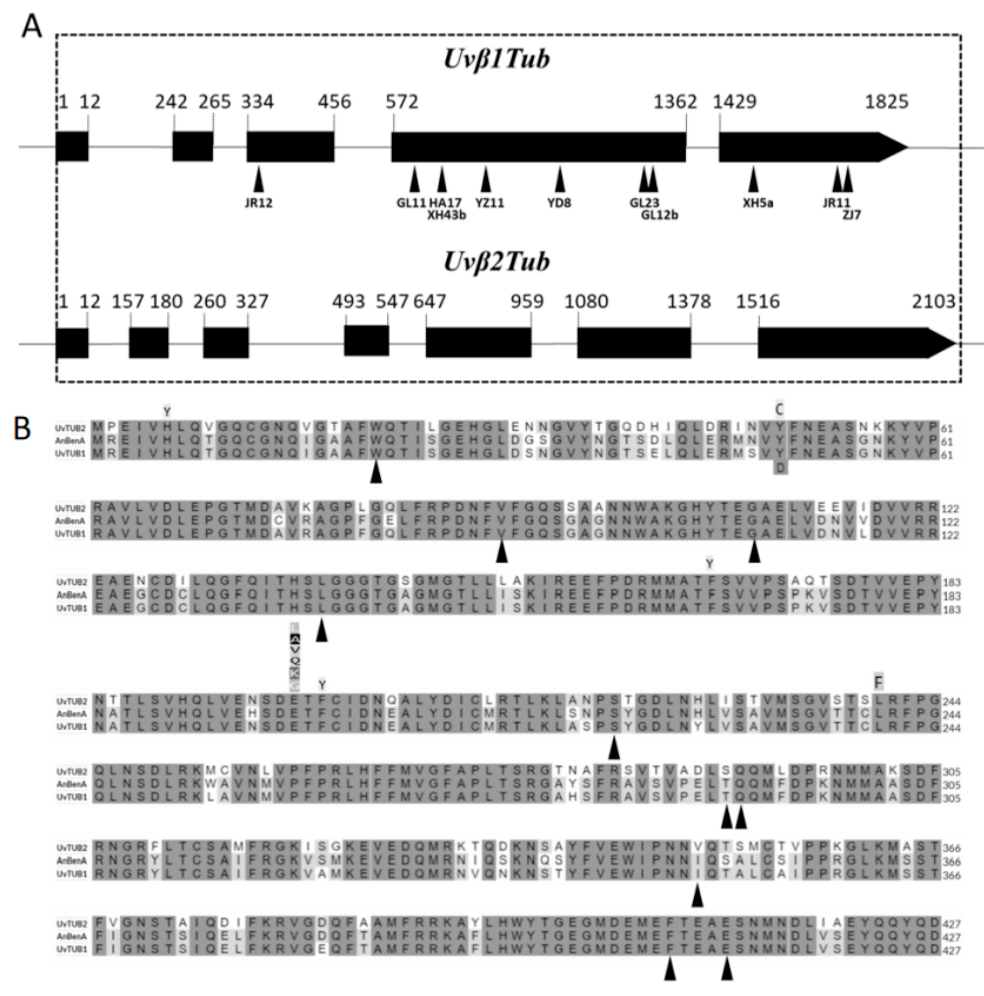
Figure 6. Schematic gene structure and alignments of Ustilaginoidea virens Uv β 1Tub and Uv β 2Tub . ( A ) Uv β 1Tub from twenty-three carbendazim-sensitive isolates is 1825 bp in size interrupted by four introns (with exons from 1–12, 242–265, 334–456, 572–1362, and 1429–1825). Locations of Uv β 1Tub variations in carbendazim-resistant isolates are marked with arrows. Uv β 2Tub from carbendazim- sensitive isolates is 2103 bp in size interrupted by six introns (with exons from 1–12, 157–180, 260– 327, 493–547, 647–959, 1080–1378, and 1516–2103). Number indicates nucleotide position of the gene. ( B ) Alignments of β -tubulin amino acid sequences from Ustilaginoidea virens and Aspergillus nidulans. The sequences of deduced amino acids of β -tubulin from A. nidulans from the NCBI GenBank database AAA3328.1. The shaded letters indicate the conserved residues. Letters above the sequences: substitution amino acids in β 2Tub from other resistant field isolates [21]. Letters under sequences: substitution amino acids in β 1Tub from resistant laboratory mutants [22,23]. The codon positions where mutations occurred in Uv β 1Tub are marked with arrows.